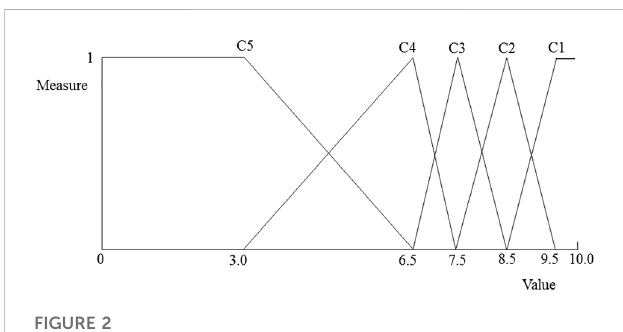
The single-index unascertained measure